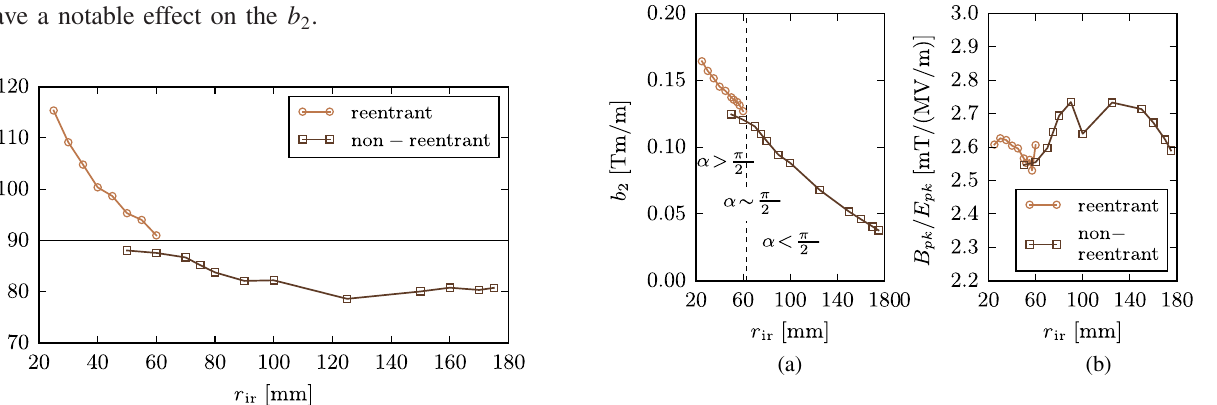
FIG. 8. (a) Maximal quadrupolar strength of the optimized cavities distinguished by their aperture assuming a magnetic peak field at the surface of B pk ¼ 100 mT. (b) The corresponding ratio of the surface peak fields B pk =E pk